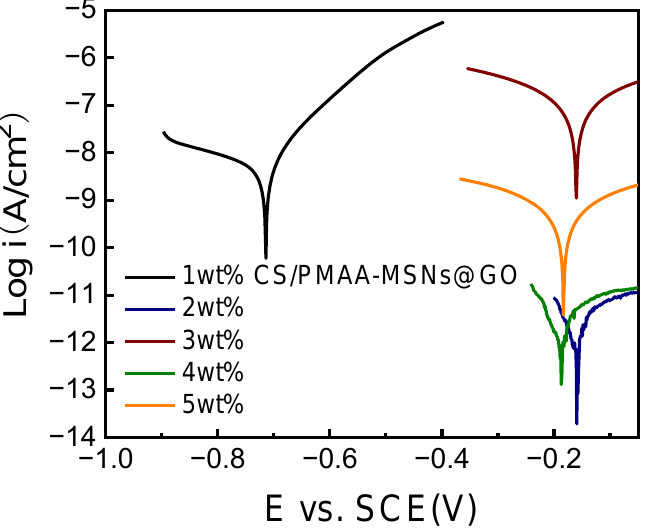
Figure 12. Tafel diagram of different coatings soaked in 3.5% NaCl immersed for 960 h. Table 3. Corrosion potential (E corr ), corrosion − current density (I corr ) of different samples after 960 h of immersion in 3.5 wt% NaCl aqueous solution.